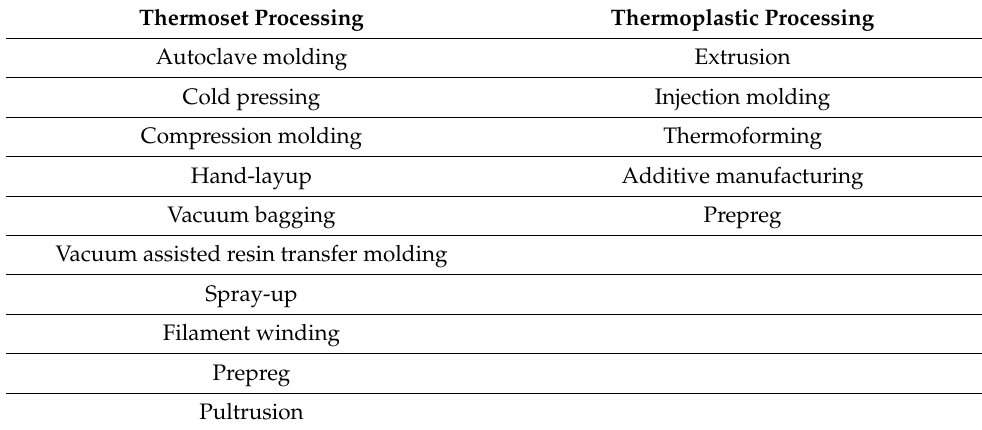
Table 2. Processing methods for hybrid